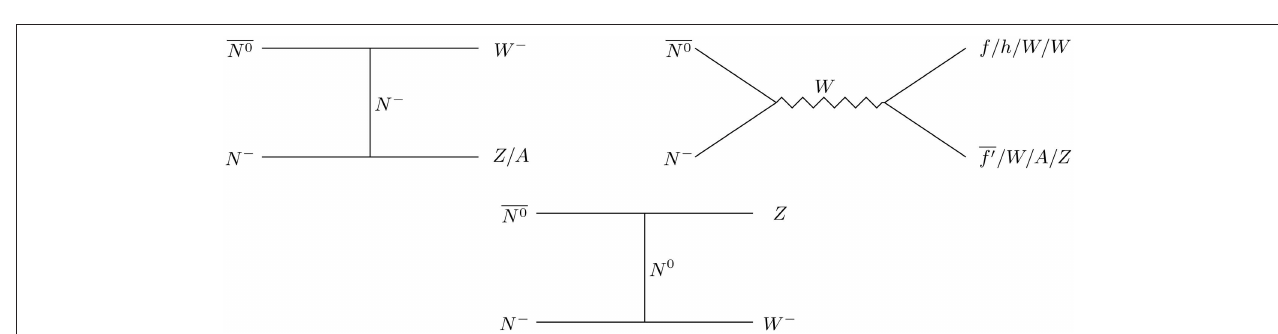
FIGURE 3 | Annihilation of charged partner of ILD DM to SM particles which contributes as co-annihilation with ILD DM.